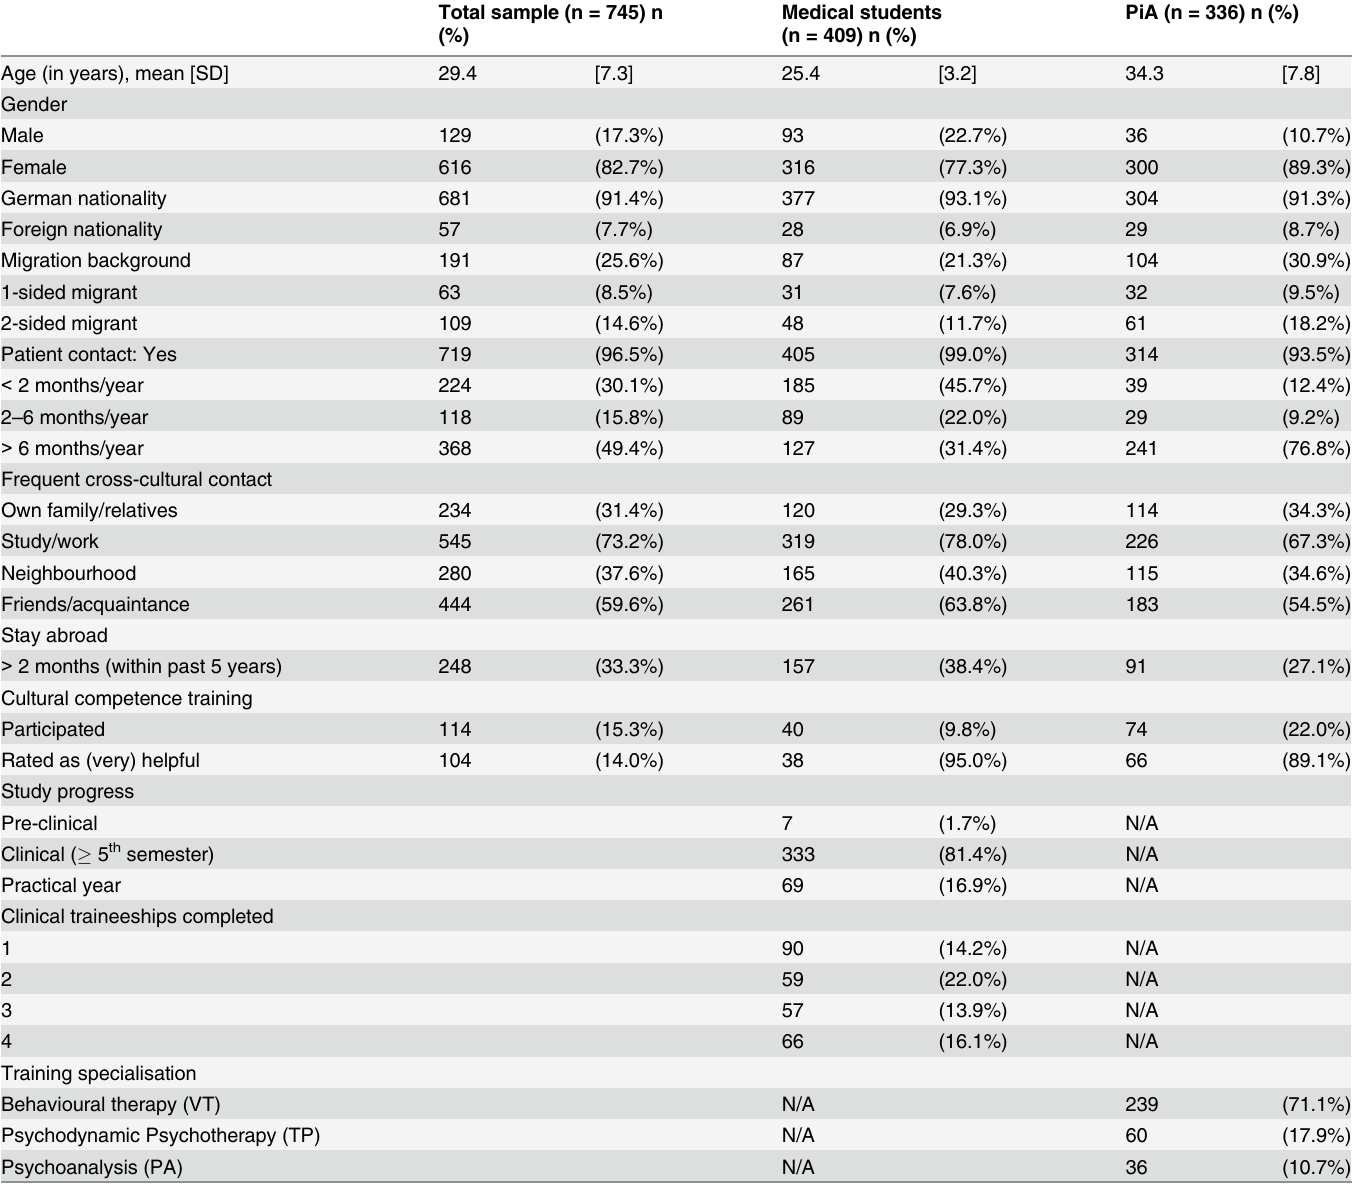
Table 1. Demographic characteristics of the medical students and PiA